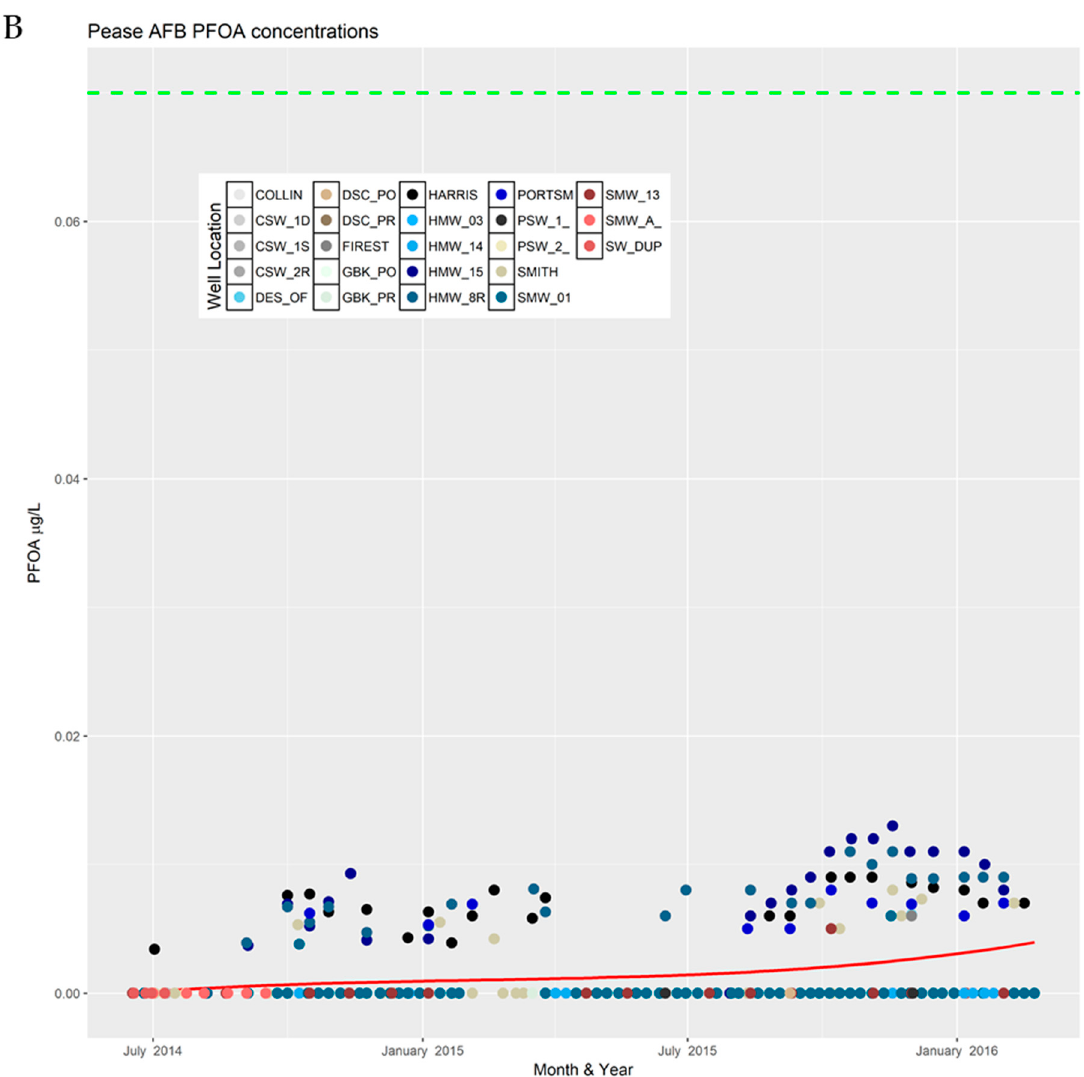
Figure 1. The above chart shows the variance in perfluorooctanoic acid (PFOA) concentrations at two different military installations. ( A ) Alaska military base; ( B ) Pease Air Force Base (AFB). Missing data were excluded from the plots.